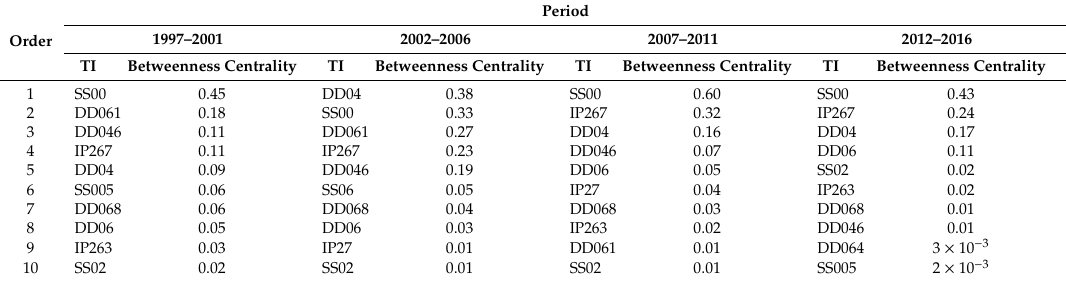
Table 5. Betweenness centrality of technological indices (TIs) by